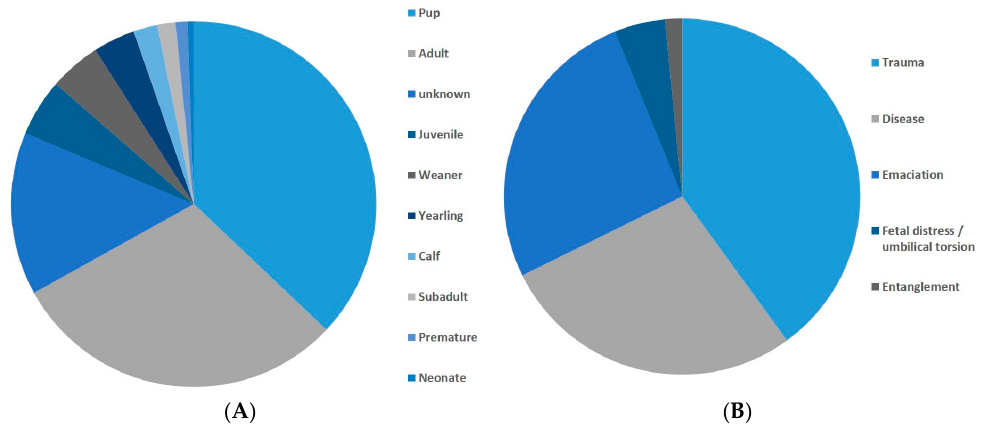
Figure 7. Dead stranded animals. ( A ) age classes. n = 375; ( B ) necropsy results n = 65.